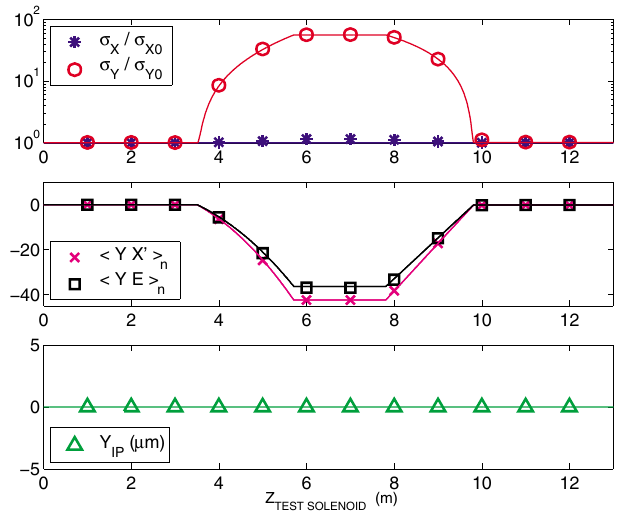
FIG. 11. (Color) Beam size, major correlations, and Y position at the IP for the short test solenoid placed on the beam axis at distance z from IP. Symbols: tracking; solid line: analytic solu- tions. IP is at z (cid:3) 0 m .